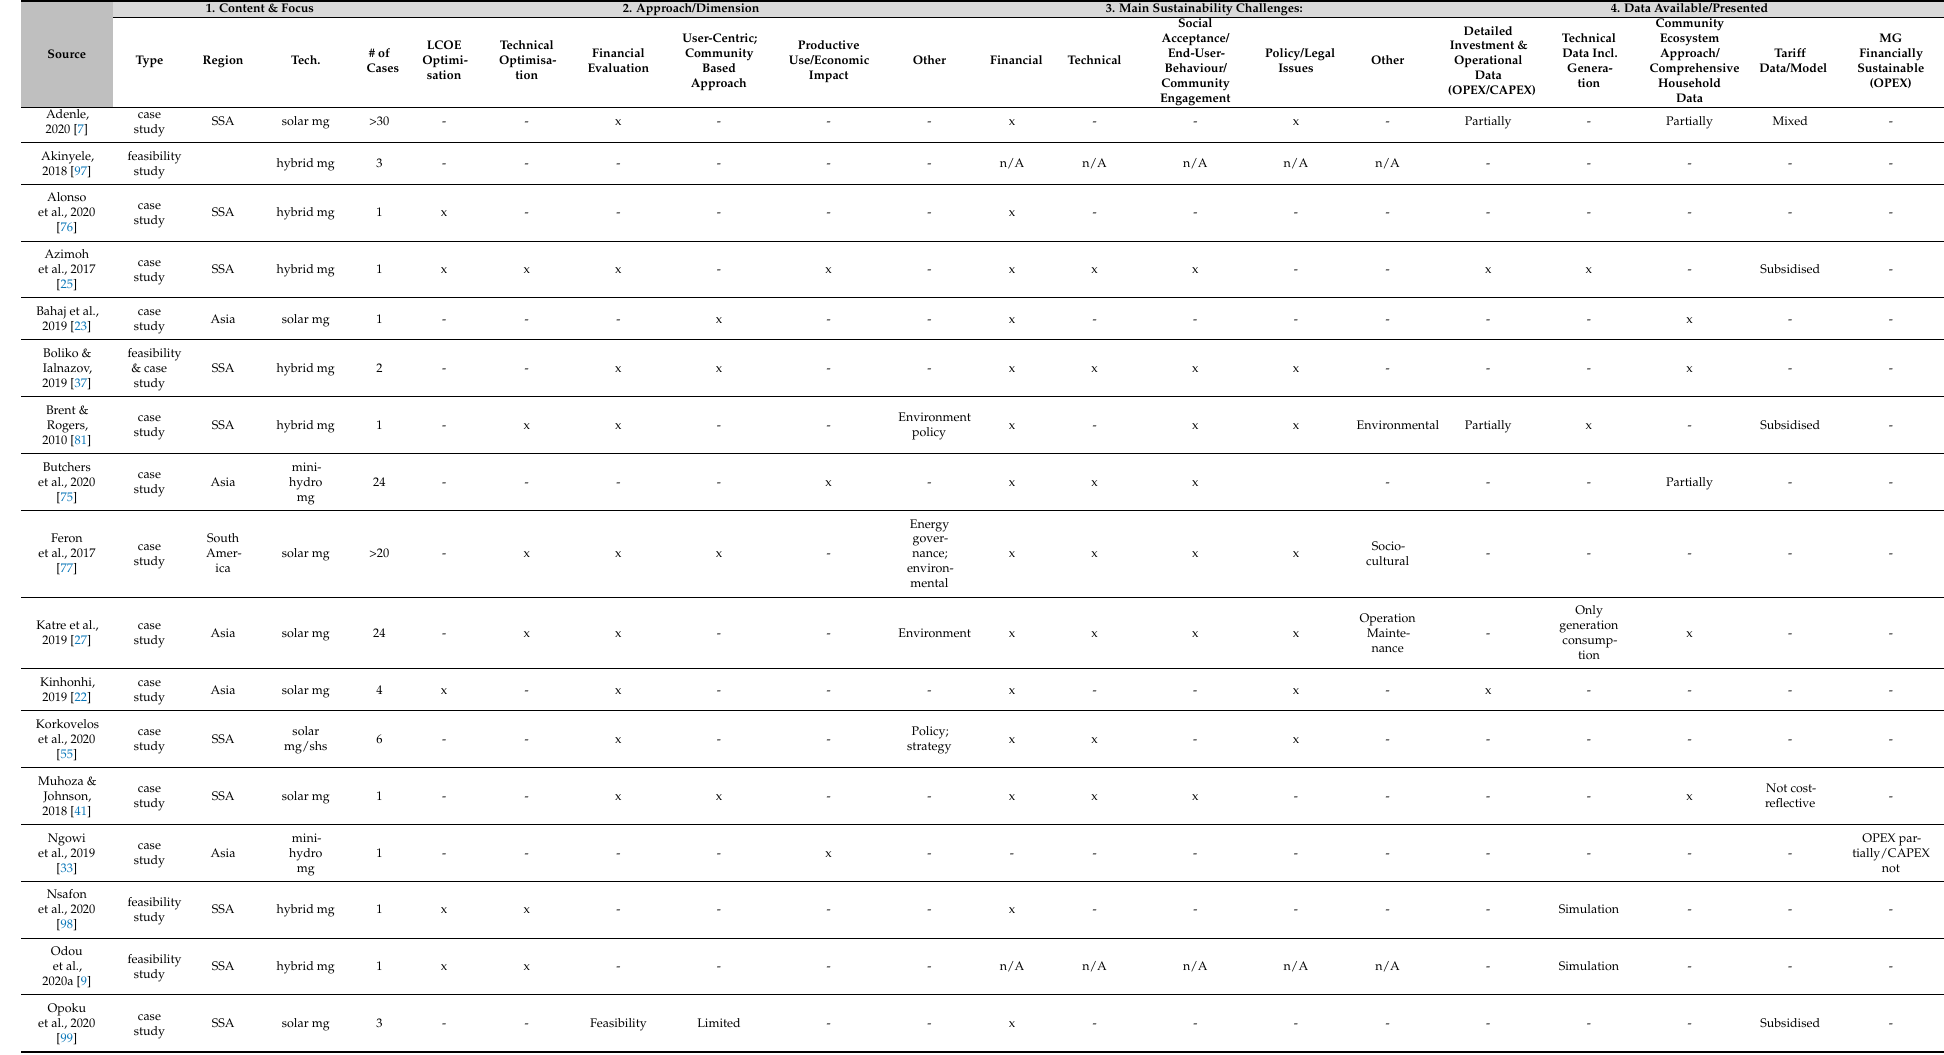
Table A2. Findings literature